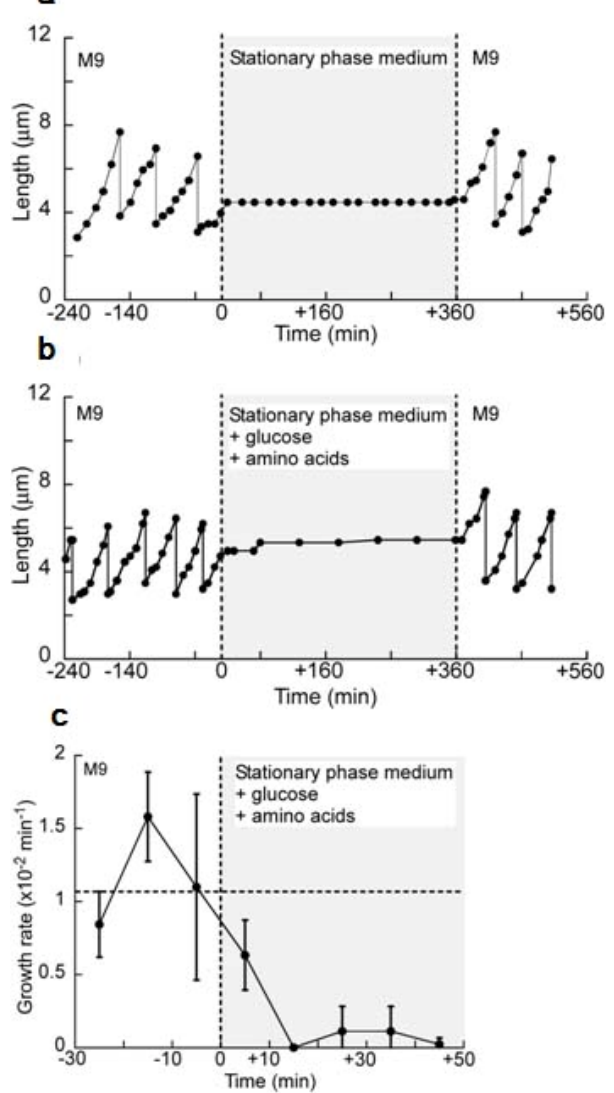
Figure 19. Response of exponentially growing cells to stationary phase